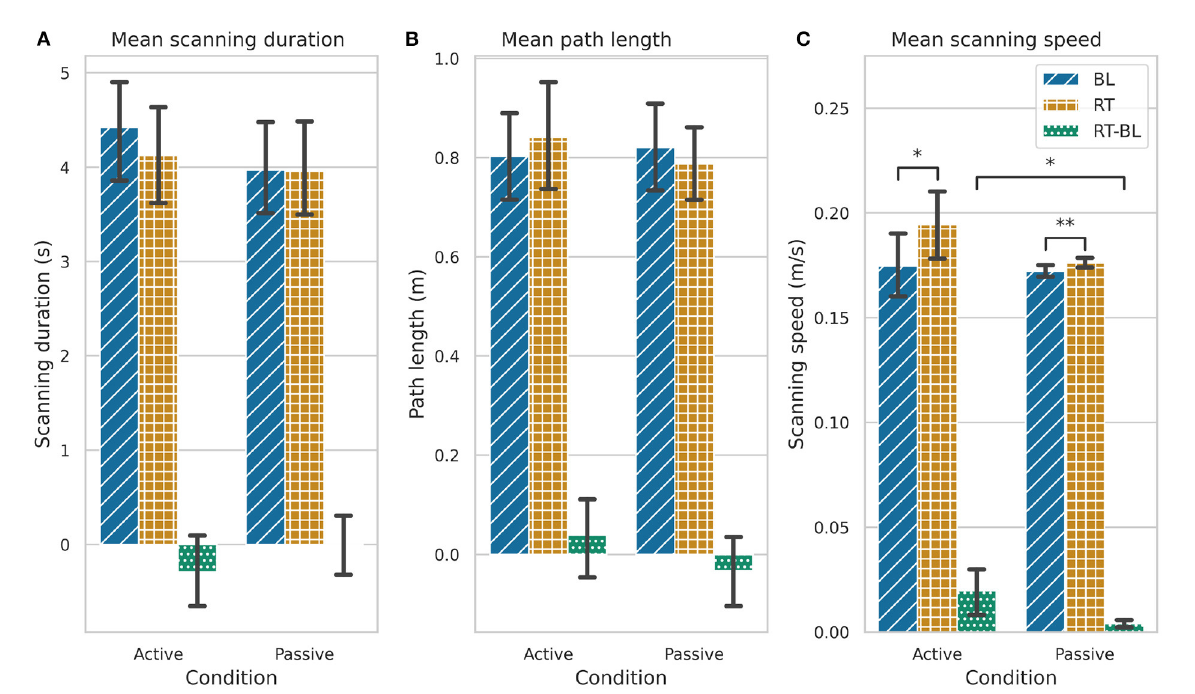
FIGURE10 Kinematic outcomes during baseline (BL), retention (RT), and the changes between baseline and retention (RT-BL) for the active and passive conditions. (A) Scanning duration. (B) Path length. (C) Scanning speed. Statistically significant differences are marked by * p < 0.05, ** p < 0.001. The error bars represent the confidence